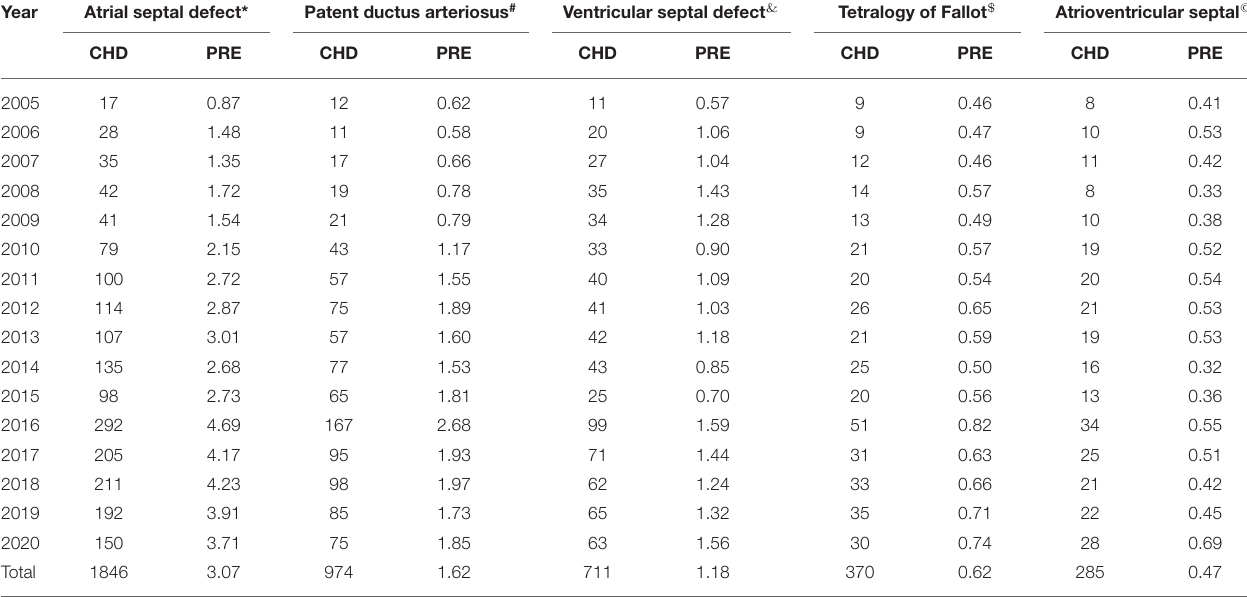
TABLE 4 | The prevalence of the the 5 most common CHD subtypes in Jinan from 2005 to 2020. Year Patent ductus arteriosus # Ventricular septal defect & Tetralogy of Fallot $ Atrioventricular septal